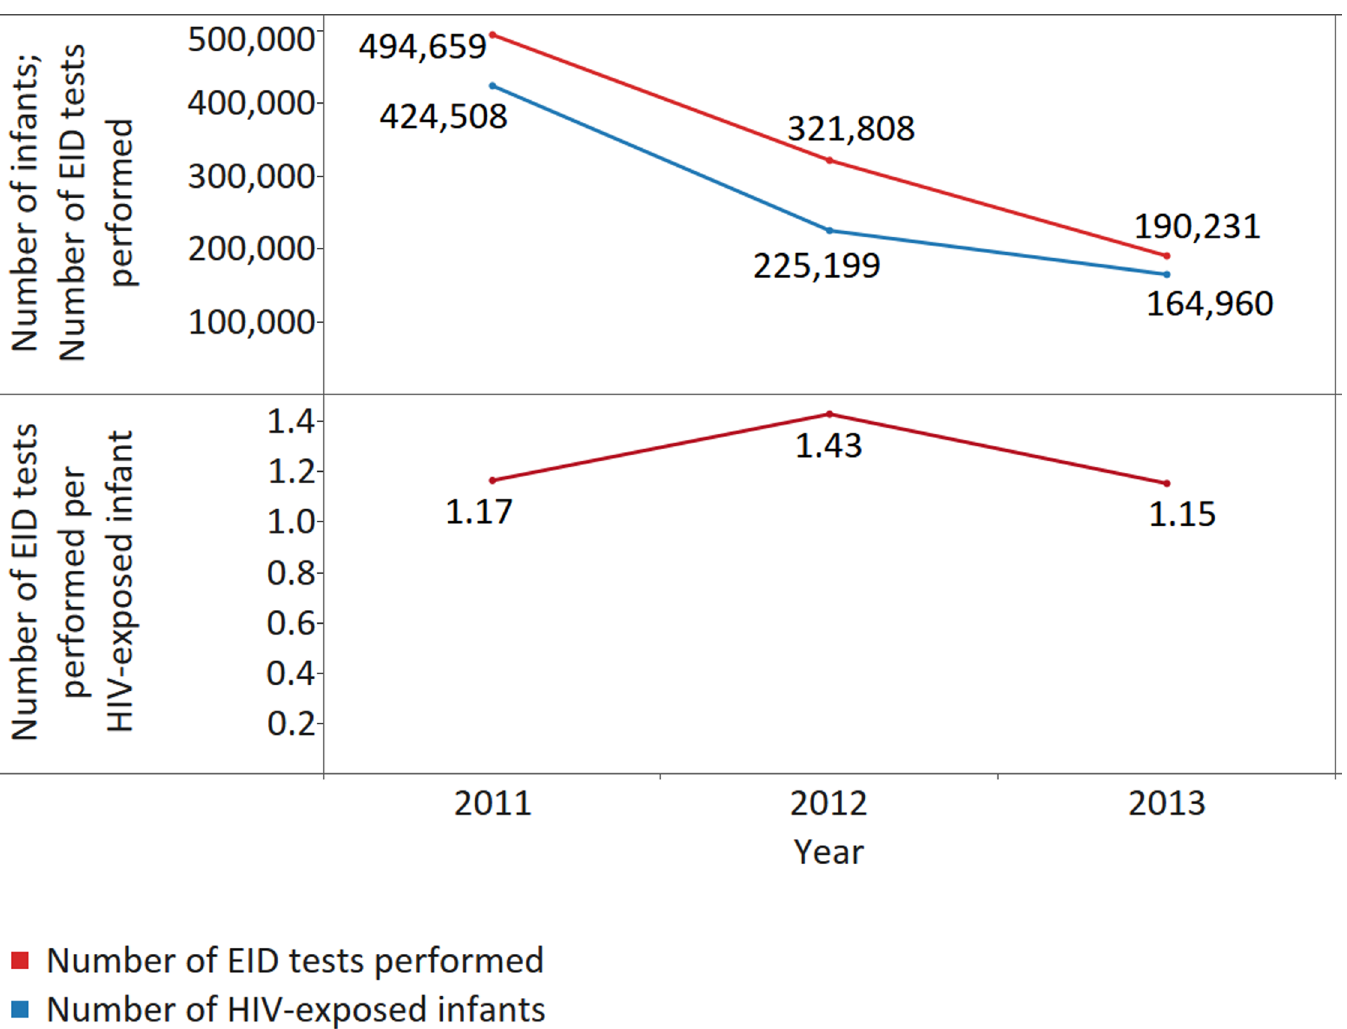
Fig 10. The number of early infant diagnosis (EID) tests performed per infant born to an HIV-positive mother per year for all reporting countries. The upper panel displays the numbers of EID tests performed and the number of infants born to HIV-positive mothers. The lower panel displays the number of EID tests performed per infant born to an HIV-positive